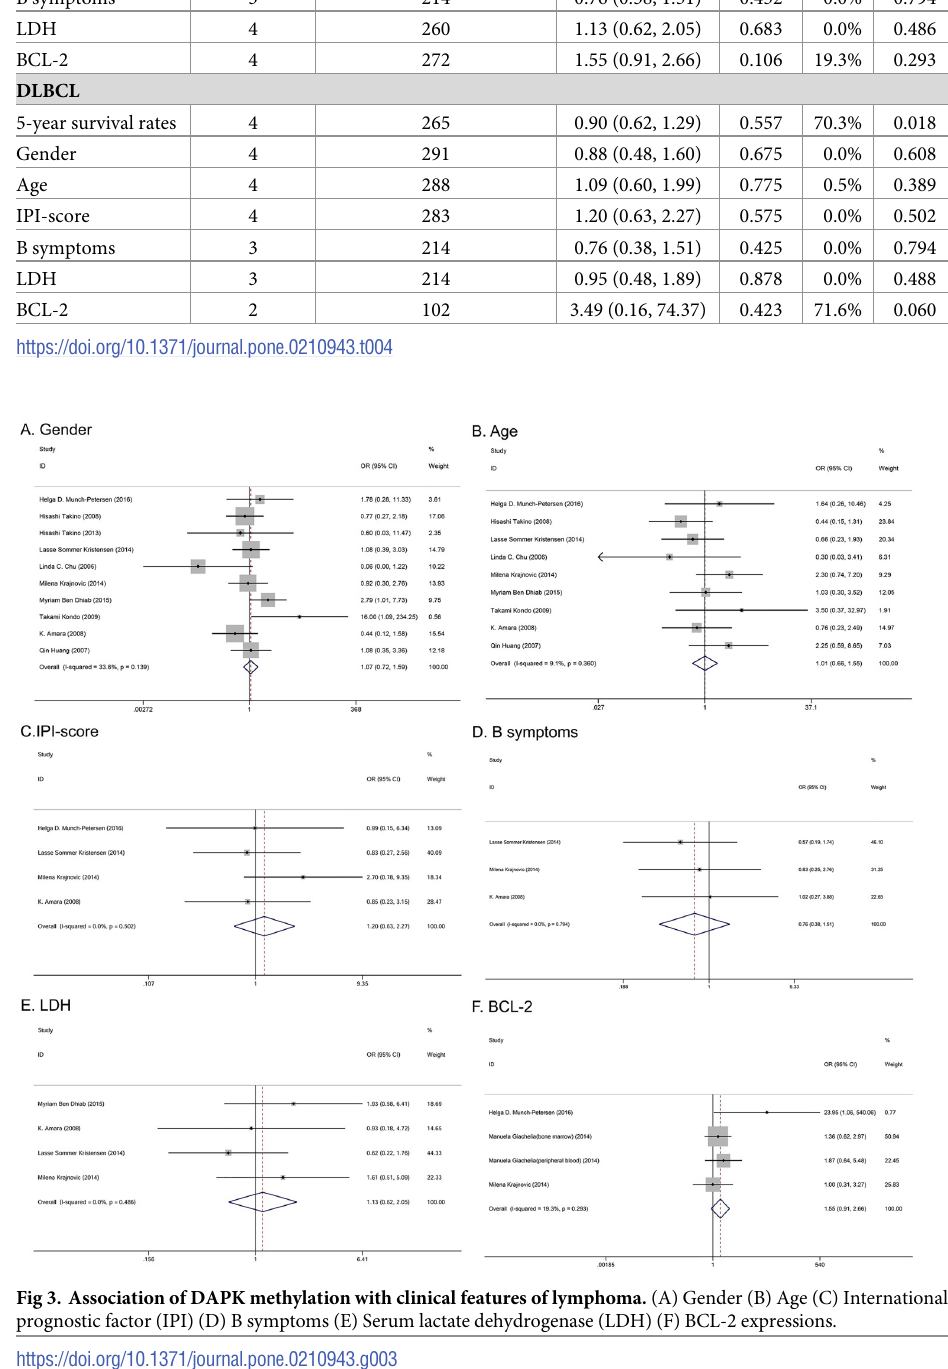
PLOS ONE | https://doi.org/10.1371/journal.pone.0210943 January 25,